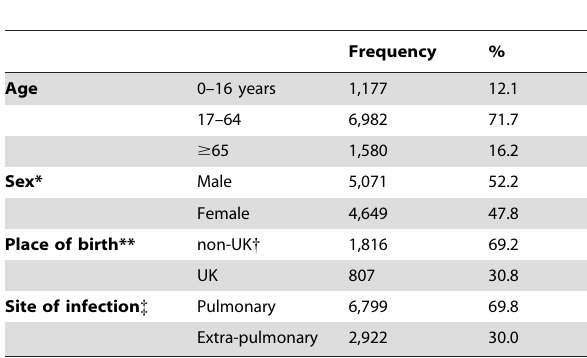
Table 1. Summary of patient